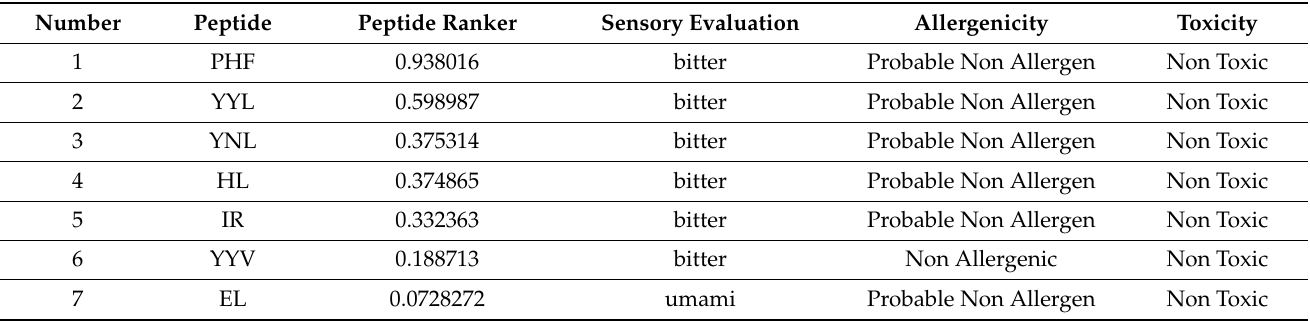
Table 4. PeptideRanker and sensory evaluation and allergenic prediction of peptides from glycinin and conglycinin as antioxidant